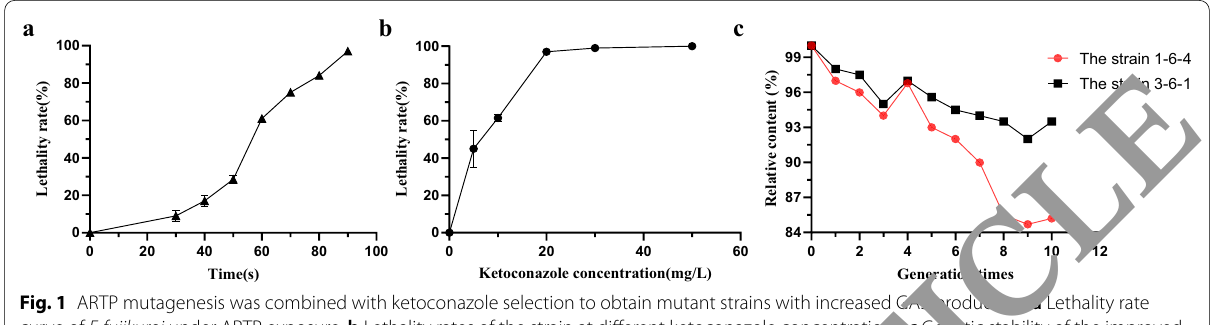
Fig. 1 ARTP mutagenesis was combined with ketoconazole selection to obtain mutant strains with increased GA3 production. a Lethality rate curve of F. fujikuroi under ARTP exposure. b Lethality rates of the strain at different ketoconazole concentrations. c Genetic stability of the improved mutants 3‑6‑1 and 1‑6‑4 during serial passaging